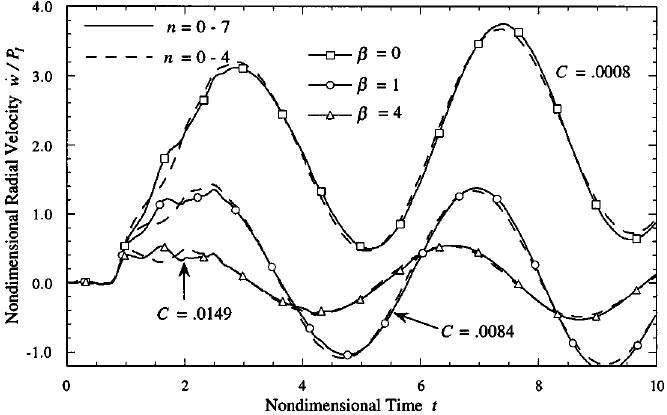
Fig. 5. Shell radial-velocity histories at (cid:18) = 0 for an empty spherical shell excited by plane step-exponential waves.